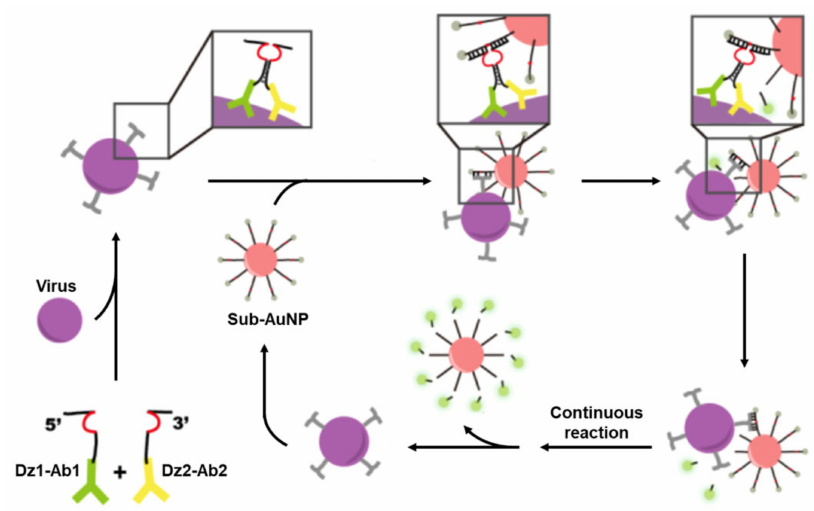
Figure 5. Principle operation of a biosensor for virus detection. The method is enabled by proximity- induced DNAzyme formation and fluorophore-labeled gold nanoparticles (AuNPs). Adapted with permission from Anal. Chem. 2021, 93, 5606–5611, doi:10.1021/acs.analchem.1c00335. Copyright (2021) American Chemical Society [42].